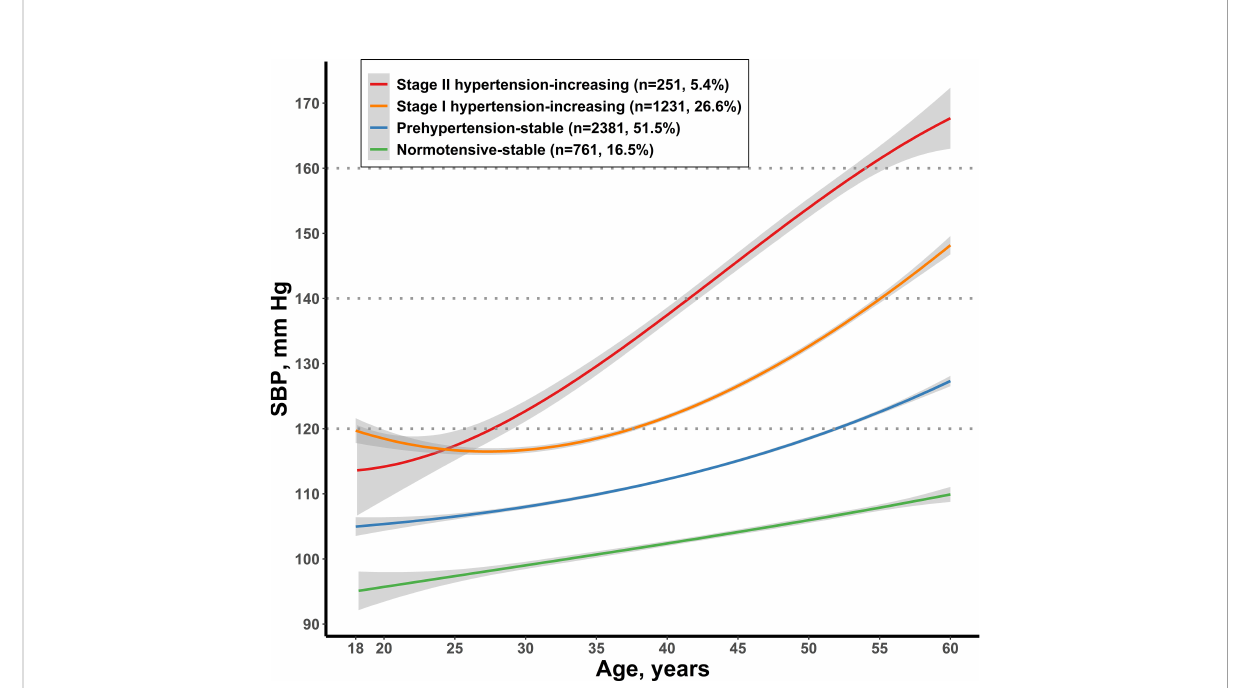
FIGURE 1 Trajectories of SBP during young adulthood. SBP, systolic blood